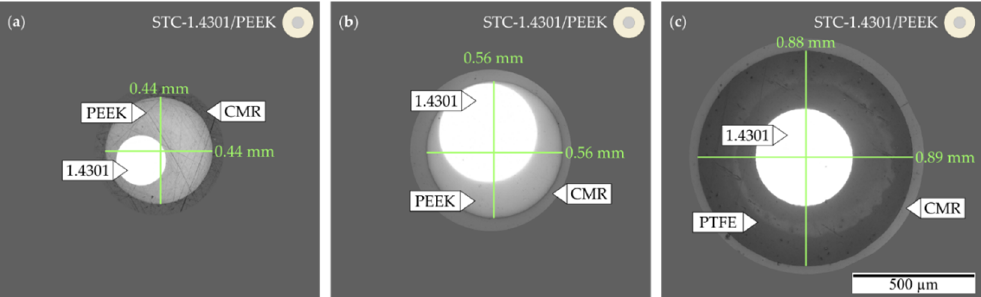
Figure 7. Photomicrographs of wire reinforced polymers manufactured by means of shrink tube consolidation (STC) embedded in cold mounting resins (CMR): ( a ) stainless steel 1.4301 / polyether ether ketone (PEEK), D = 0.46 mm; ( b ) 1.4301 / PEEK, D = 0.59 mm; ( c ) 1.4301 / polytetrafluoroethylene (PTFE), D = 0.84 mm.